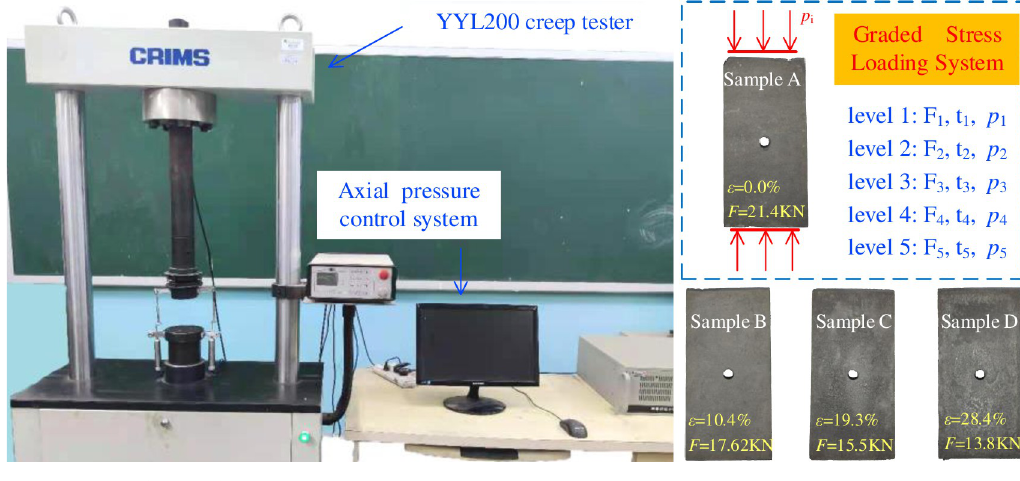
Fig 4. Diagram showing the test